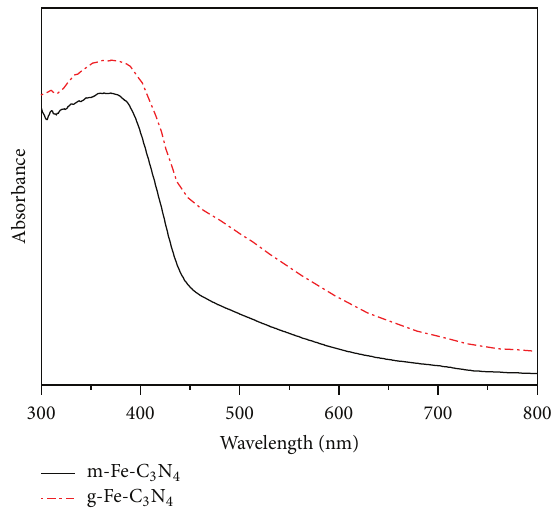
Figure 6: UV-vis absorption spectra of the g-Fe-C 3 N 4 and m-Fe-C 3 N 4 samples.